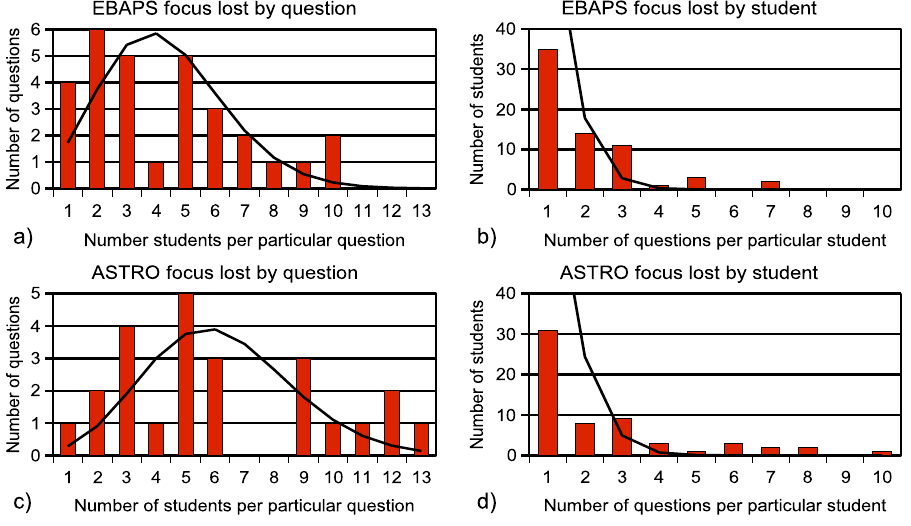
FIG. 2. (cid:1) Color online (cid:2) Frequencies of focus-lost events on both assessments compared to distribution for completely random events. Significant deviations from a random (cid:1) binomial (cid:2) distribution are probable indications of students using other applications while taking the